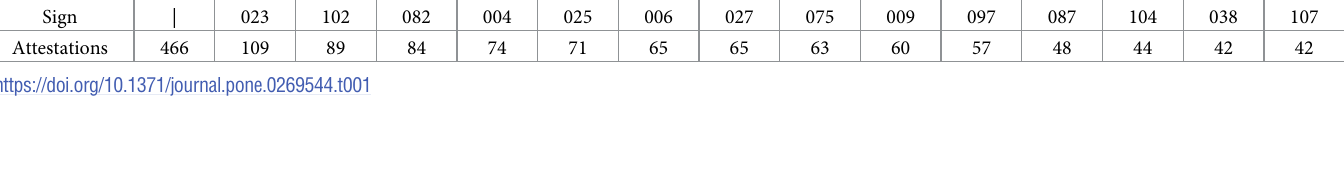
(CNN or Convnet) [29] represent a computational model able to carefully analyse images from different perspectives and perform different tasks on them, consistently reaching very high rates of success. As almost all neural systems dealing with images in some capacity are based on CNN [30], they seemed most fitting to our purposes. We based our model on an unsupervised method called DeepClusterv2. This model uses a CNN with residual connections (ResNet) [31], a specific kind of CNNs, to perform automatic clustering of images. DeepCluster-v2 is based on DeepCluster [32], which uses a K-Means clustering algorithm to extract pseudo-labels from the images, which in turn are used to train a classifier over them (Fig 4). The clustering step happens on normalized (unit-norm) vectors and uses a dot product as the distance metric, which is equivalent to cosine distance on an hypersphere. The main issue of this model, however, is that the classification layer used to train the model on the